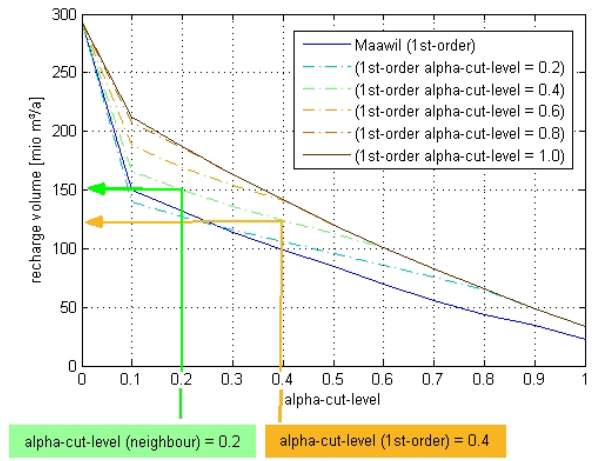
Fig. 10. Exemplary evaluation of results for α -cut-level (first-order – Maawil) = 0.4 and conditional α -cut (neighbour – Farah) =